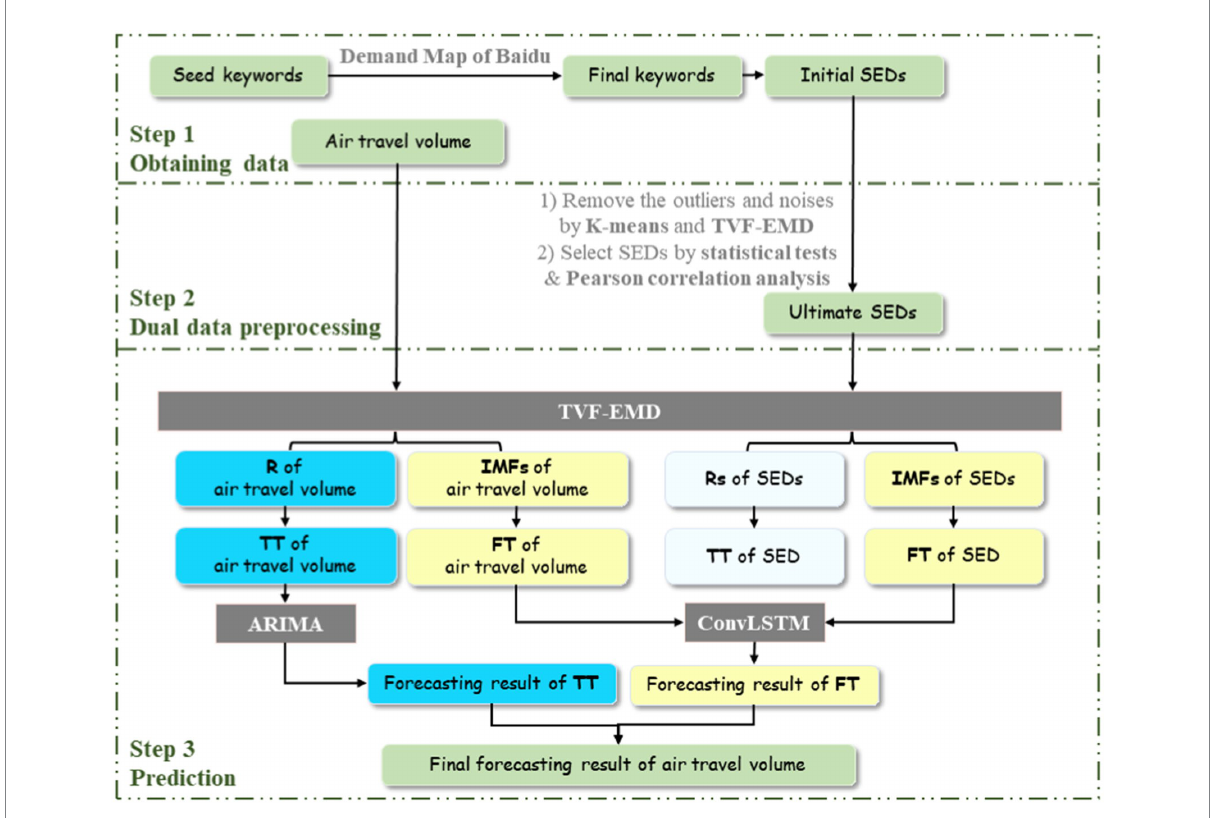
FIGURE 3 The structure of SED-DDP-TVFEMD-ConvLSTM ensemble forecasting